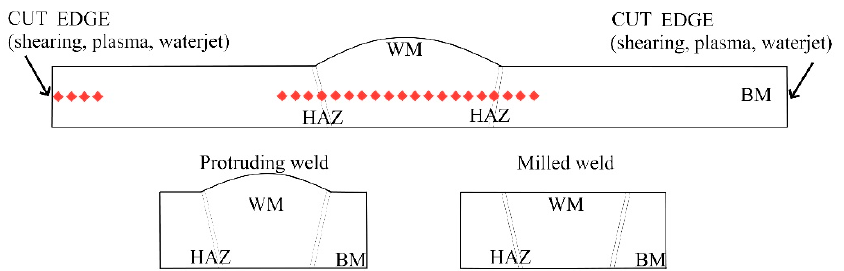
Figure 3. Sheets after waterjet cutting and MIG welding. The welded sheets were cut to obtain ten- sile test specimens and samples for microstructural observation and micro-hardness measures. A: Sample for weld observation and micro-hardness; the arrow indicates the side of observation. B: Sample for edge observation and micro-hardness; the arrow indicates the side of observation. C: Milled weld. D: Protruding weld. Table 3. Specification for specimen studied/tested. Specimens Realized